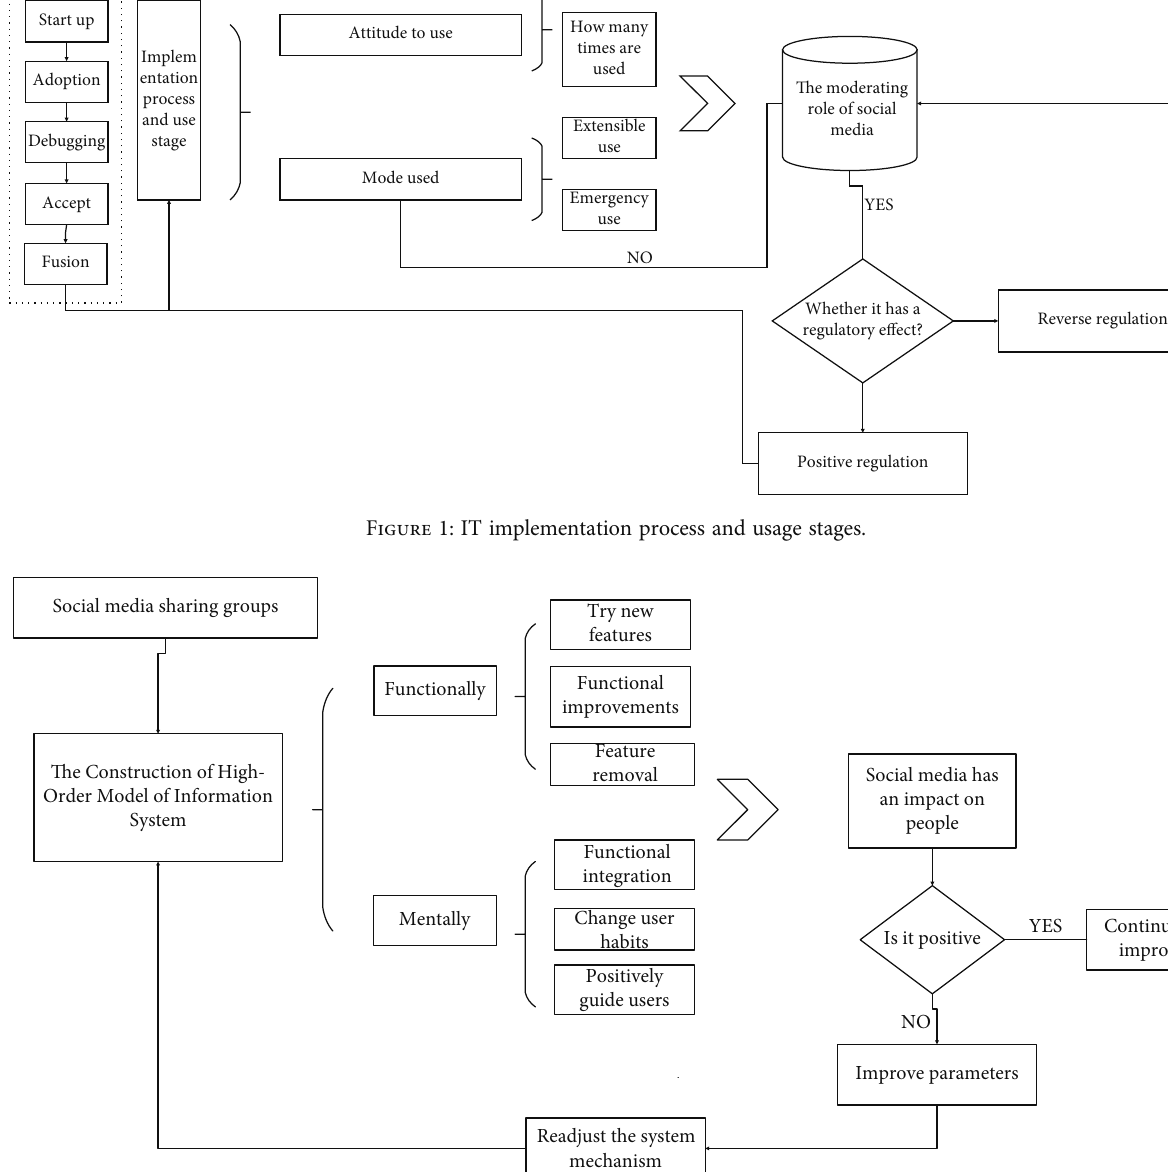
Figure 2: On the construction of the higher-order model of the adaptive information